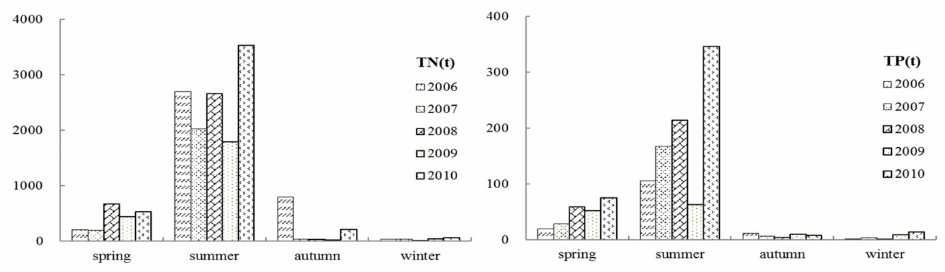
Figure 5. Temporal distribution of TN and TP loads in the Liao River source area for 2006 to 2010.